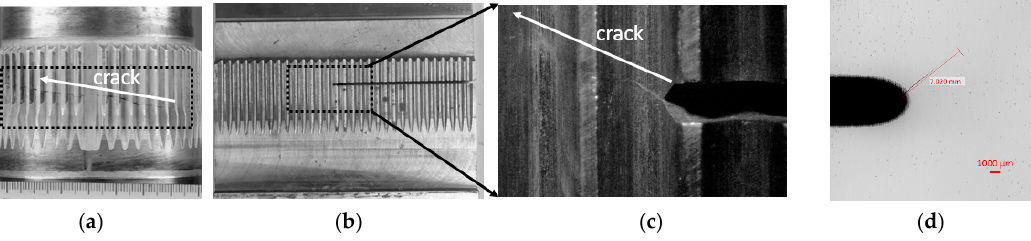
Figure 3. The comparison of cracks directions in the NAVAIR gearbox test and the UIC fatigue test, ( a ) gear spline; ( b ) planar spline; ( c ) microscopic image of crack growth at the planar spline; and ( d ) the acoustic microscope image of the crack measured from the back surface of the planar spline.